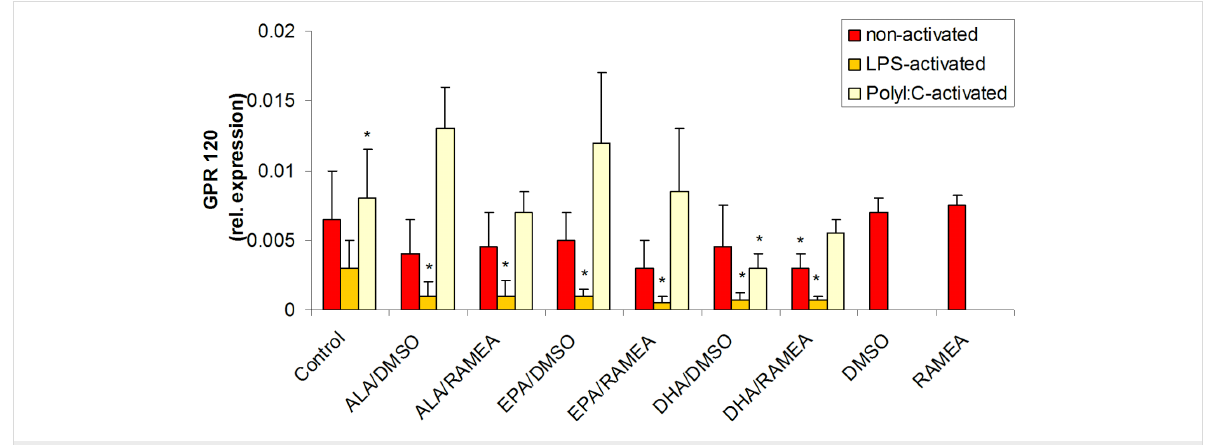
Figure 7: The effect of n − 3 PUFAs on the expression of GPR120 receptor in resting (red), LPS-activated (yellow) and Poly(I:C)-activated (white) moDC ( N = 6) (* p < 0.05 compared to the control).